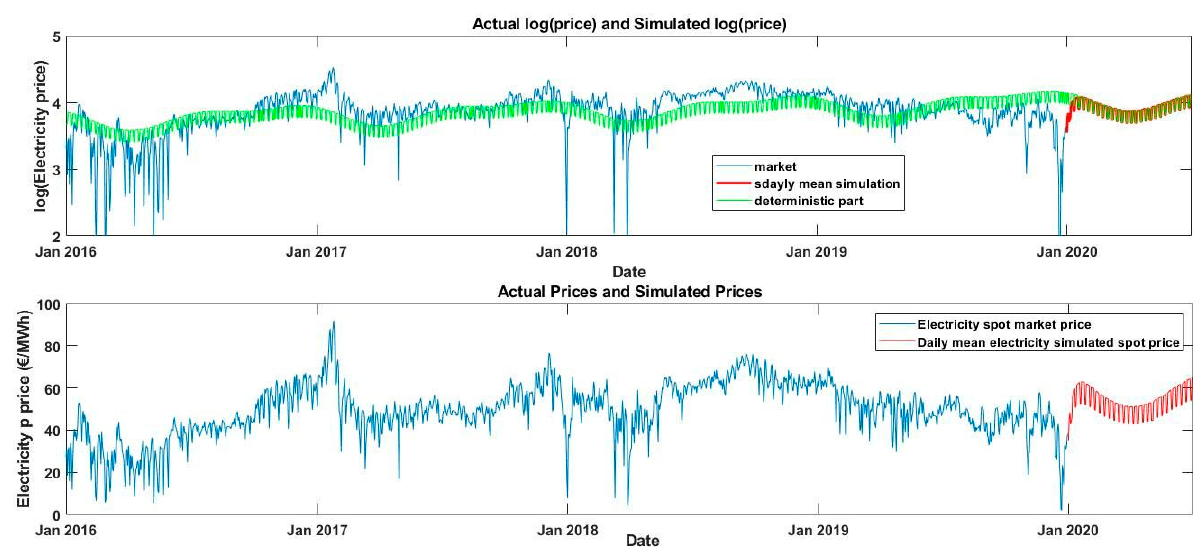
Figure 6. Daily natural logarithm of Spanish electricity prices from 2016 to 2019 and daily mean of simulated prices for the first half-year of 2020.